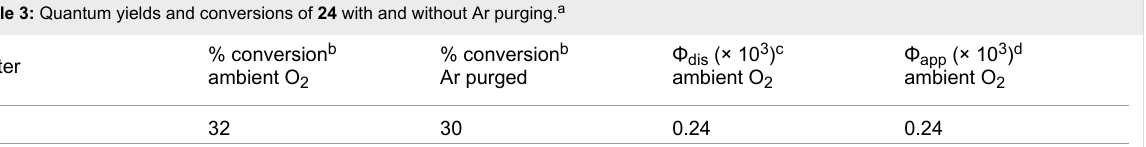
a Solvent was 10% H 2 O in MeCN. Photolyses were conducted with 300 or 350 nm lamps. b Determined using 1 H NMR in 10% D 2 O in CD 3 CN; c Determined with 1 H NMR for the disappearance of the starting material at 350 nm with air; d Determined with 1 H NMR for the appearance of diethyl phosphate at 350 nm with air.